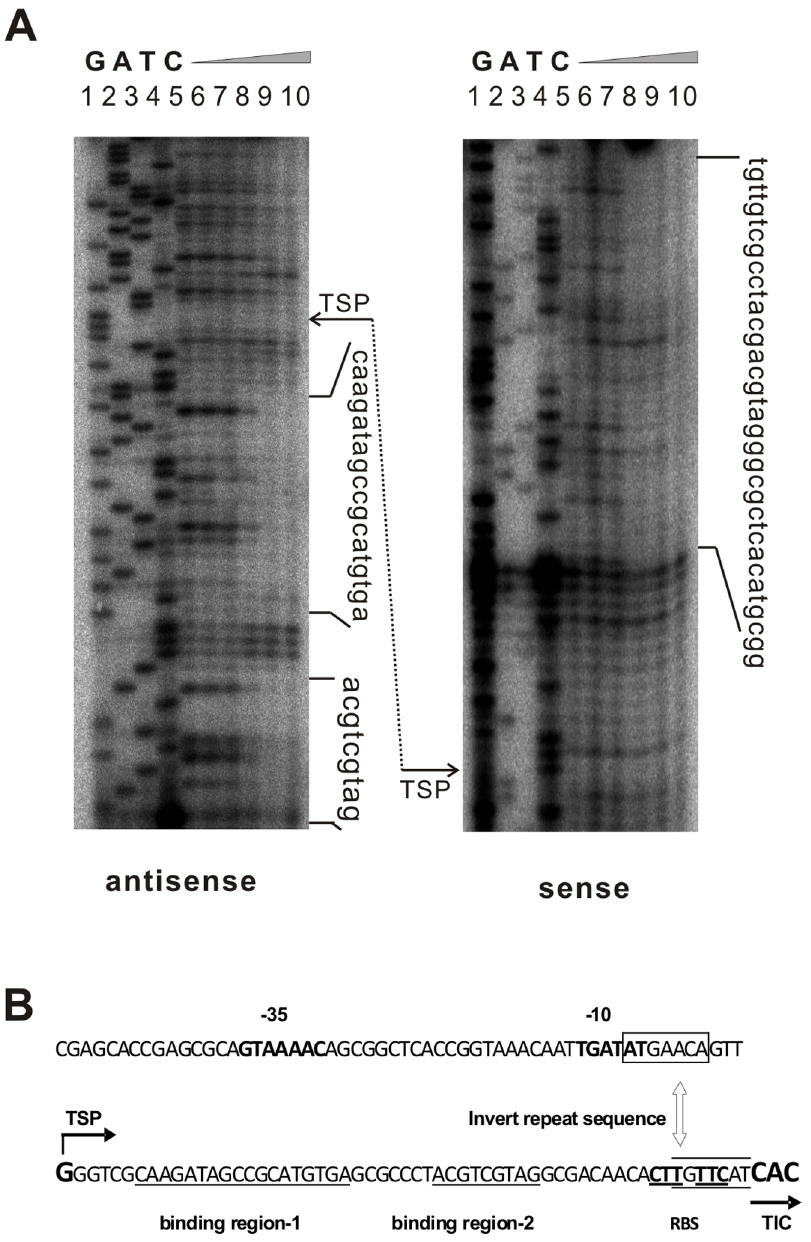
Figure 6. Analysis of the Mur34 binding site by DNase I footprinting assay. (A) Analysis of antisense strand c - 32 P labeled DNA (left) and the sense strand c - 32 P labeled DNA (right) upstream of mur33 . Lanes G (1), A (2), T (3) and C (4) are sequencing ladder. Samples from lands 5–10 contain the same amount of the binding DNA with an increasing amount (0–3.2 m g m l -1 ) of purified His 6 Mur34. The complexes from the samples were digested by DNase I (0.004U per10 m l) at 30 u C for 1 min. The vertical sequences to the right of each gel picture indicate the DNA regions protected from the cleavage of DNase I. The transcription start point (TSP) was shown for each DNA strand. (B) ‘‘G’’ indicates the TSP. The sequences underlined were the protected regions by His 6 Mur34 under DNase I, ‘‘CAC’’ indicates the translation initiation codon (TIC), the bold regions upstream of TSP are - 10 ‘‘TGATAT’’ and -35 ‘‘GTAAAACAG’’ regions. The bases in the boxes found are palindromes, and the bold and underlined bases near the TIC are supposed to be the Shine-Dalgarno